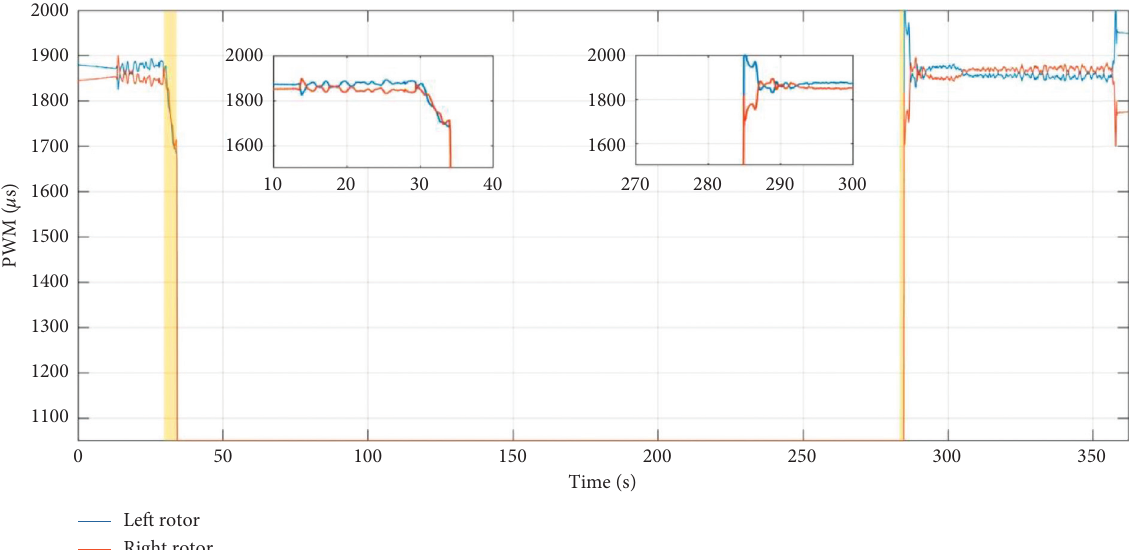
Figure 22: Tilting commands of two front rotors in the flight